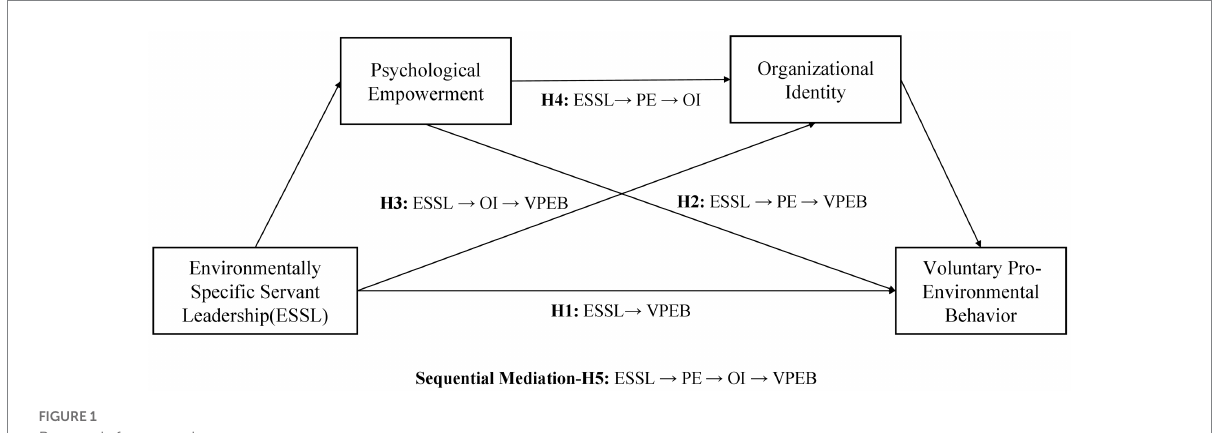
FIGURE 1 Research